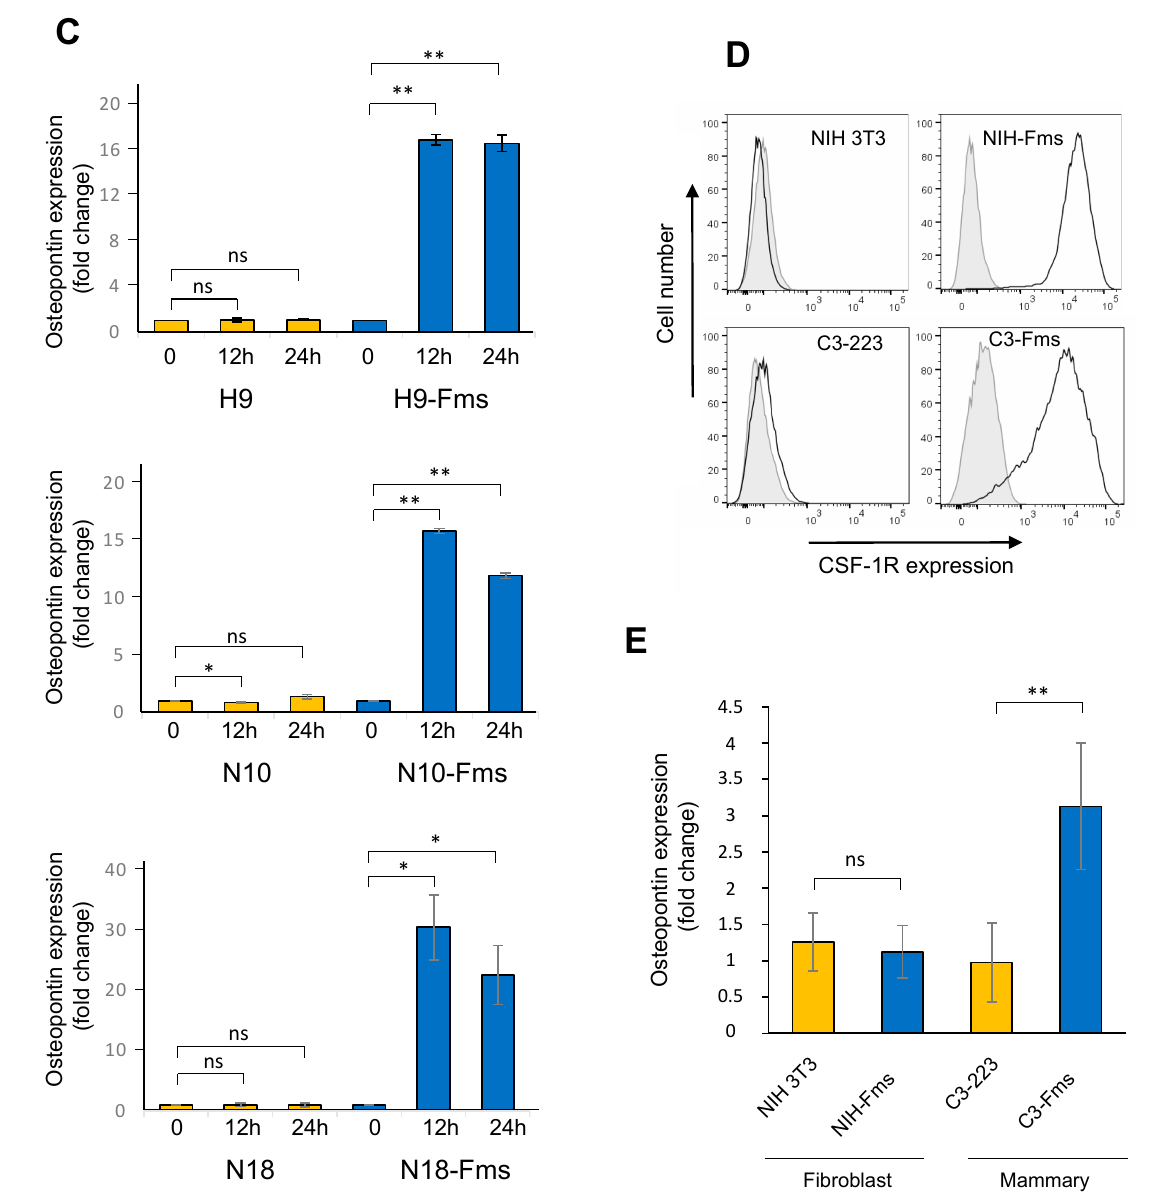
Figure 5. CSF-1 increases spp1/osteopontin mRNA expression in murine macrophages, prostate cancer cells and breast cancer cells. ( A ) Representative image (n = 3) of Bac1.2F5 murine macrophages cultured in the presence of CSF-1. ( B ) Relative expression of spp1/osteopontin mRNA was assessed by qRT-PCR performed in triplicate (normalized against RPLP38). Starved Bac1.2F5 cells were cultured or not in the presence of CSF-1 for 12 or 24 h. ( C ) Relative expression of spp1/osteopontin mRNA was assessed by qRT-PCR performed in triplicate (normalized against RPLP38). H9 and H9-Fms prostate cells (upper panel), N10 and N10-Fms prostate cells (middle panel), and N18 and N18-Fms prostate cells (lower panel) were cultured or not in the presence of CSF-1 for 12 or 24 h. ( D ) murine c- fms cDNA encoding CSF-1R was transduced in murine fibroblast NIH3T3 cells